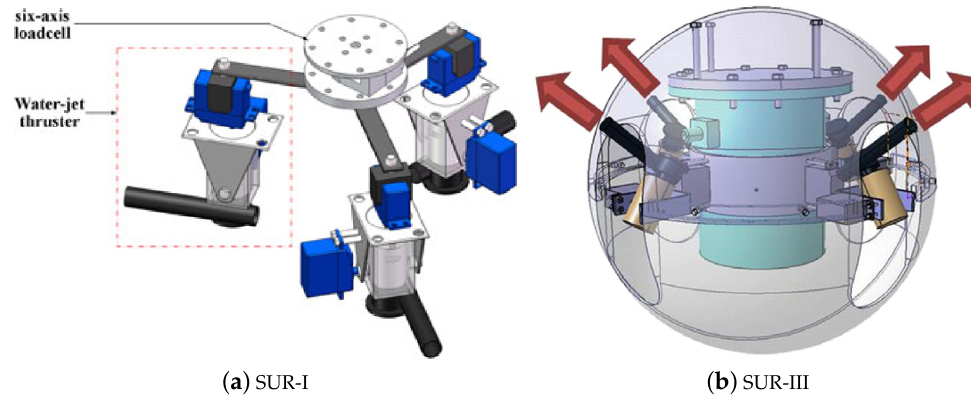
Figure 8. The evolution of SUR robot